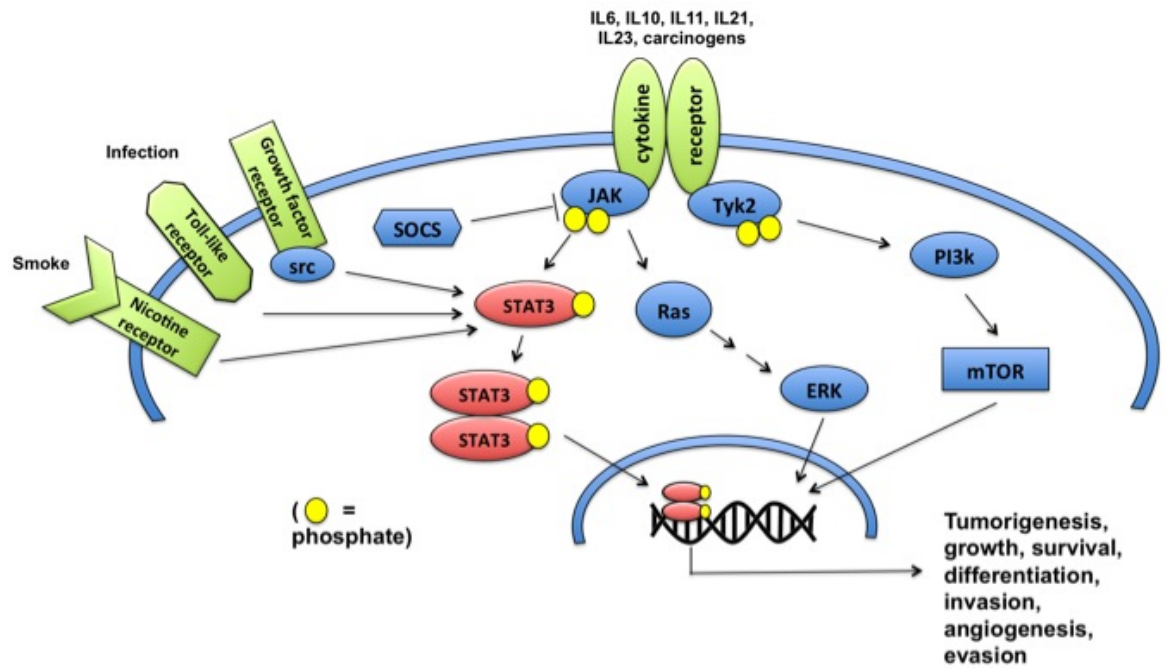
Figure 1. STAT3 as convergence point in the oncogenic